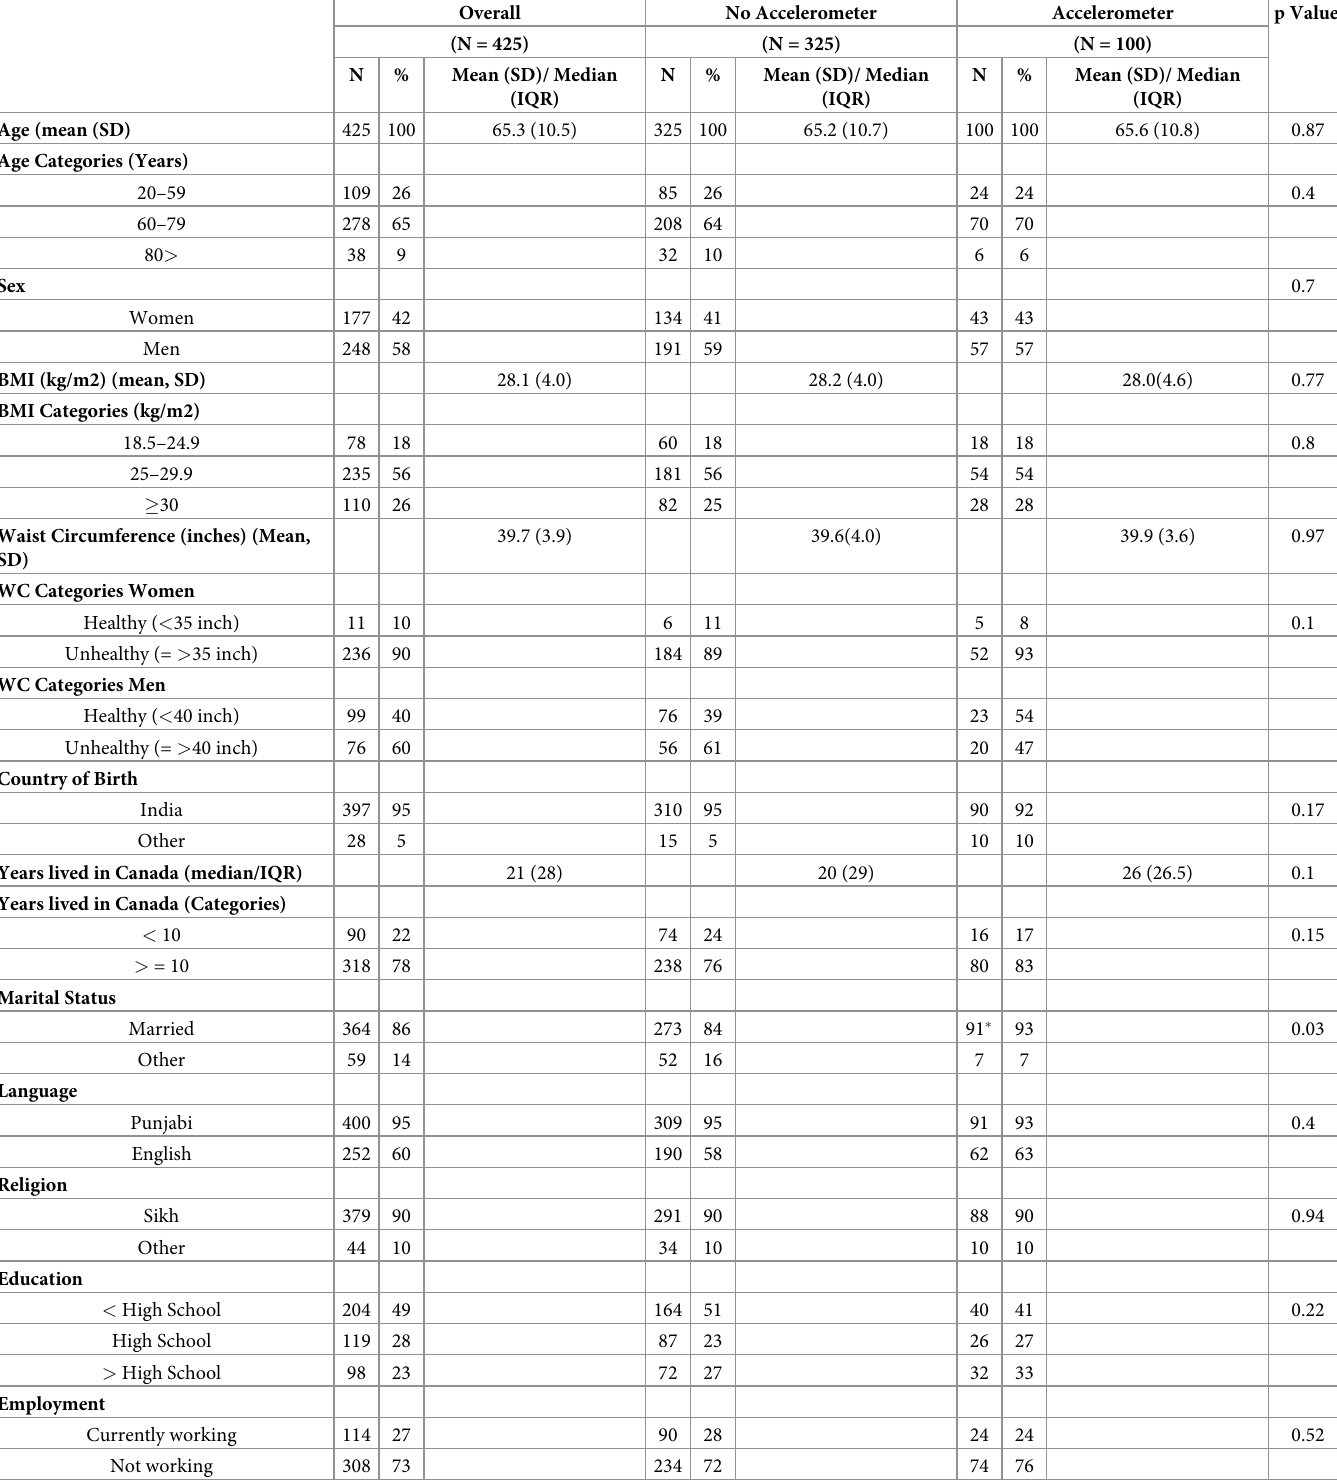
Table 1. Socio-demographic characteristics of participants in the parent study (n = 425), the non-accelerometer sample (n = 327) and the accelerometer sub-study (n = 100).